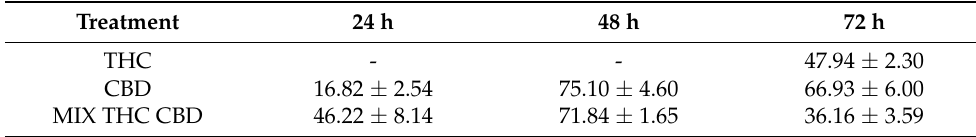
Table 5. IC 50 of THC, CBD, and MIX THC CBD against HepG2 cells as determined by the MTT